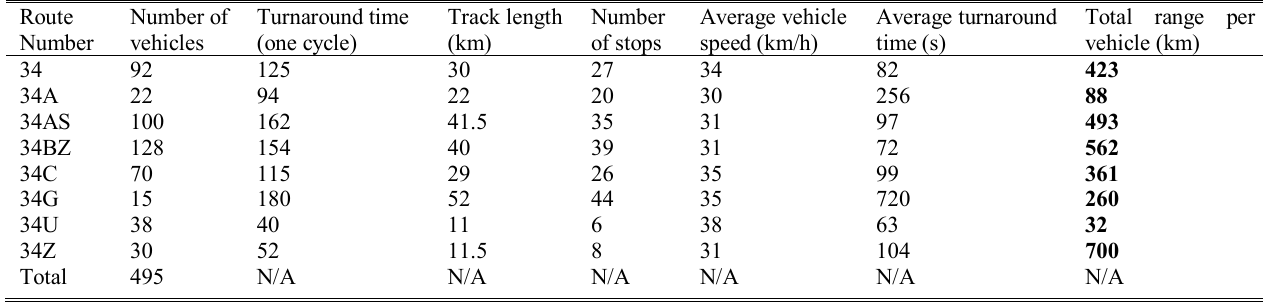
METROBUS LINE GENERAL